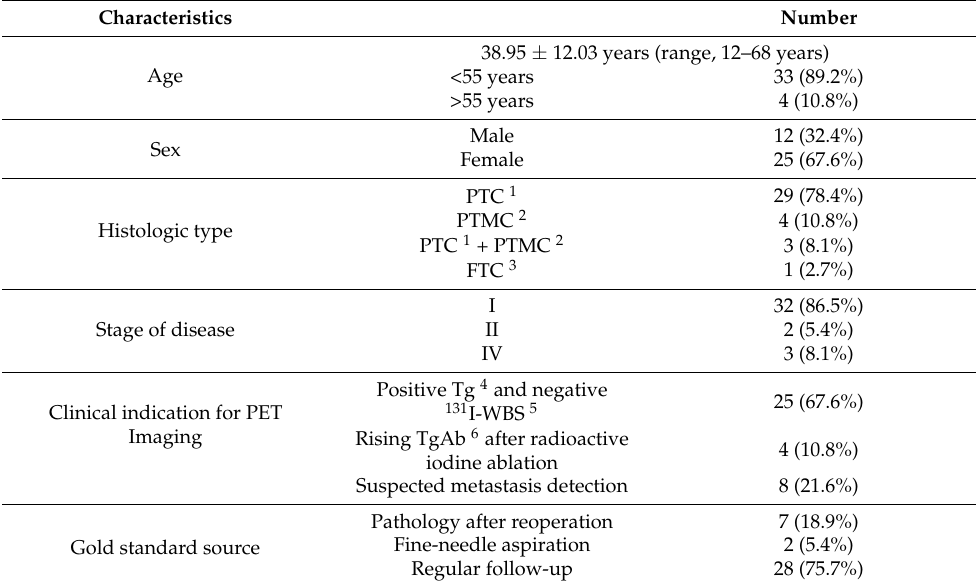
Figure 1. Flow chart of patients who were referred for assessment. Table 1. Patients’ characteristics.